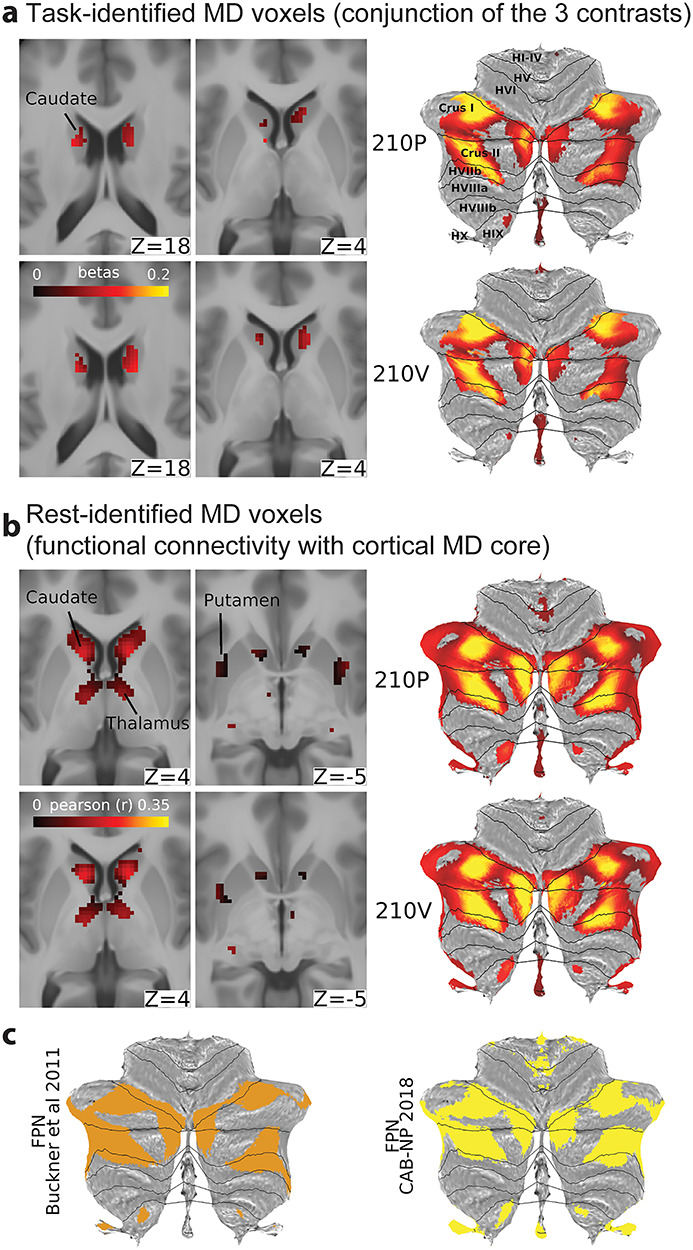
Subcortical and cerebellar MD components. (a) Left: conjunction of significant voxels across the three tasks for the 210P (top) and 210V (bottom). Right: cerebellar activity is displayed on a flat cerebellum with lines representing anatomical borders (Diedrichsen and Zotow 2015). Data available at http://balsa.wustl.edu/Z4NXp. (b) Left: subcortical voxels with significant connections to the cortical core MD areas. Right: cerebellar MD connectivity displayed on a flat map. Data available at http://balsa.wustl.edu/VjwZg. (c) FPN from Buckner et al. (2011) (left) and Ji et al. (2018) (right). Data available at http://balsa.wustl.edu/3g7wv.